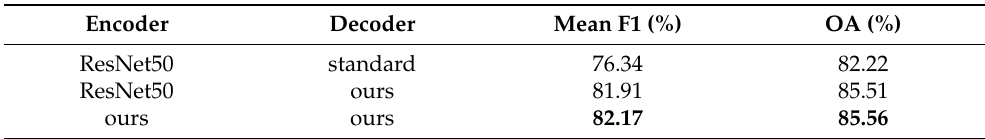
Table 5. Comparison of different encoders on our method with direct bilinear interpolation upsam- pling. The bold indicates the best